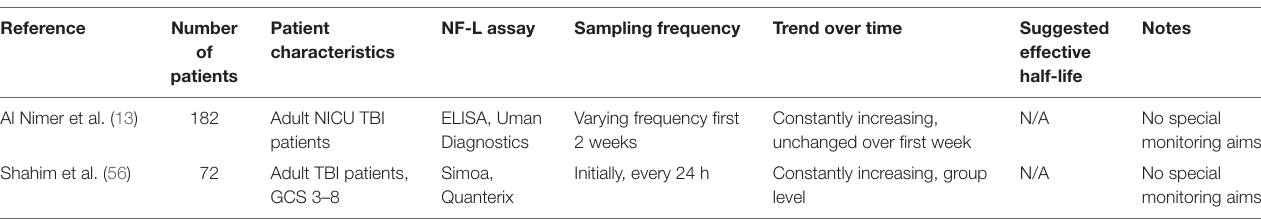
TABLe 5 | Analysis of NF-L